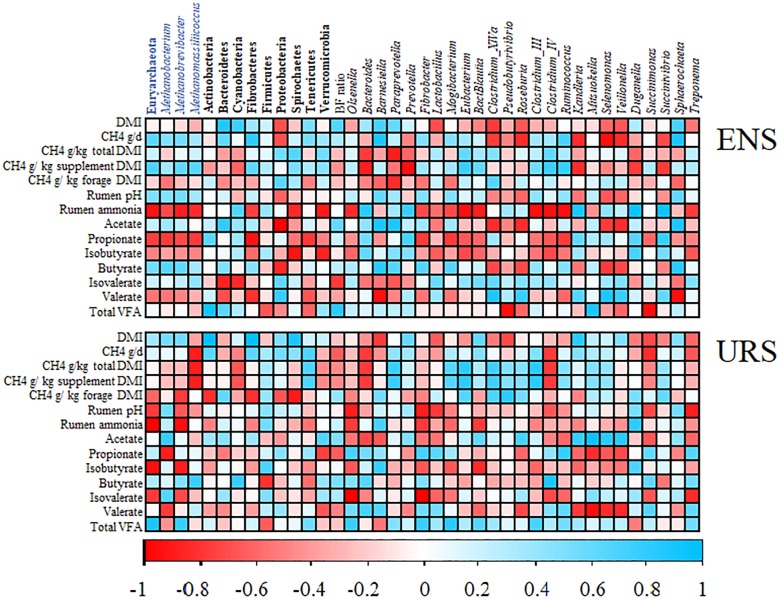
Correlation analysis between dry matter intake, methane emissions, rumen fermentation parameters and relative abundances of ruminal microbial taxa in encapsulate nitrate supplementation (ENS) and urea supplementation (URS) groups. Spearman’s correlation values for phylum/genera across all samples was performed and only significant correlations (P < 0.10) for at least one of the analyzed variables are shown. Names in blue and black indicate archaeal and bacteria taxa, respectively. Names in bold and italics indicate phylum and genera level, respectively. CH4, methane emissions; DMI, dry matter intake expresses as kg per day; VFA, volatile fatty acids.